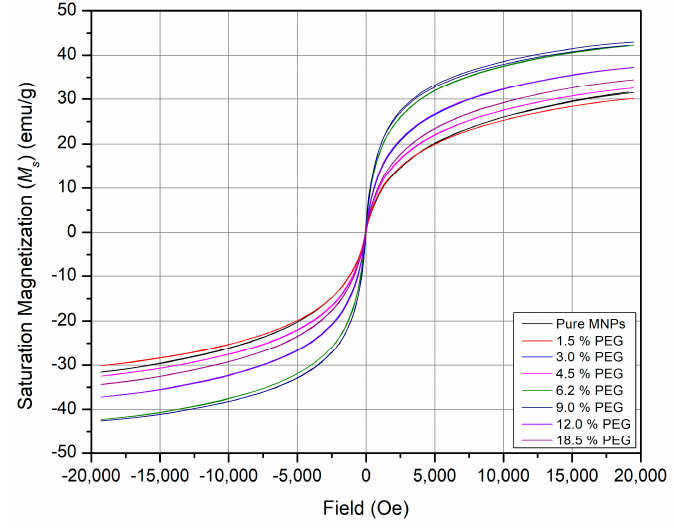
Figure 4. Magnetization hysteresis of the as-prepared PEG-coated MNPs as a function of the concentration of PEG.